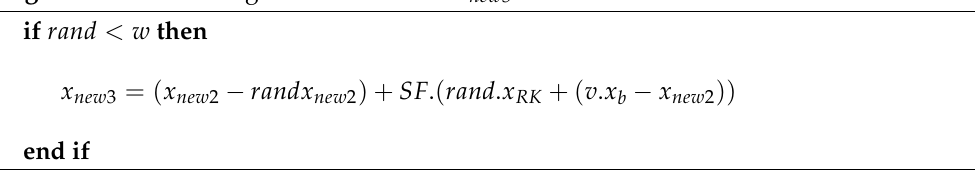
Algorithm 3 Enhancing the new solution x new